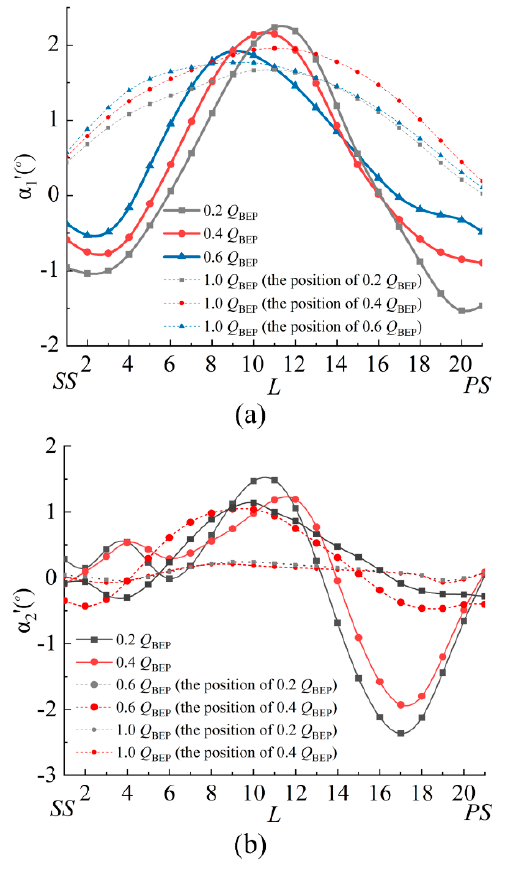
Figure 10. Absolute flow angle distributions along arc 1 and arc 2 under the rotational speed of 1000 r/min. Suction side ( a ) and pressure side ( b ).